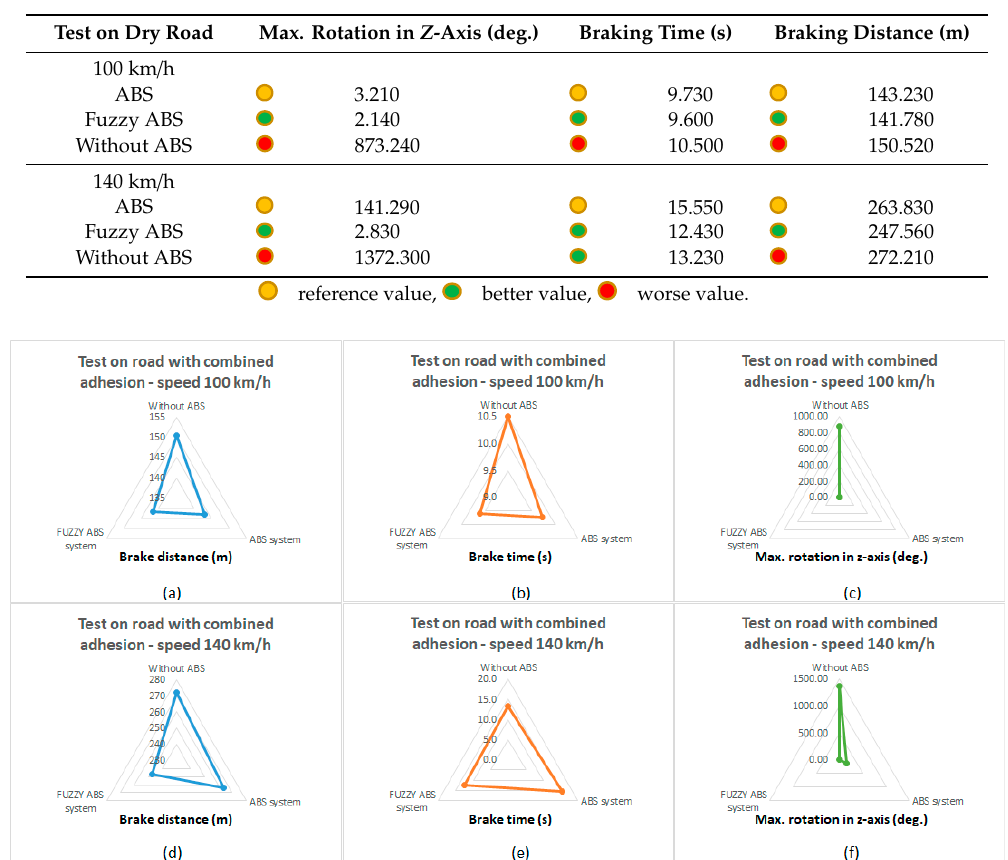
Table 10. Comparison of parameters when braking on road with combined adhesion.